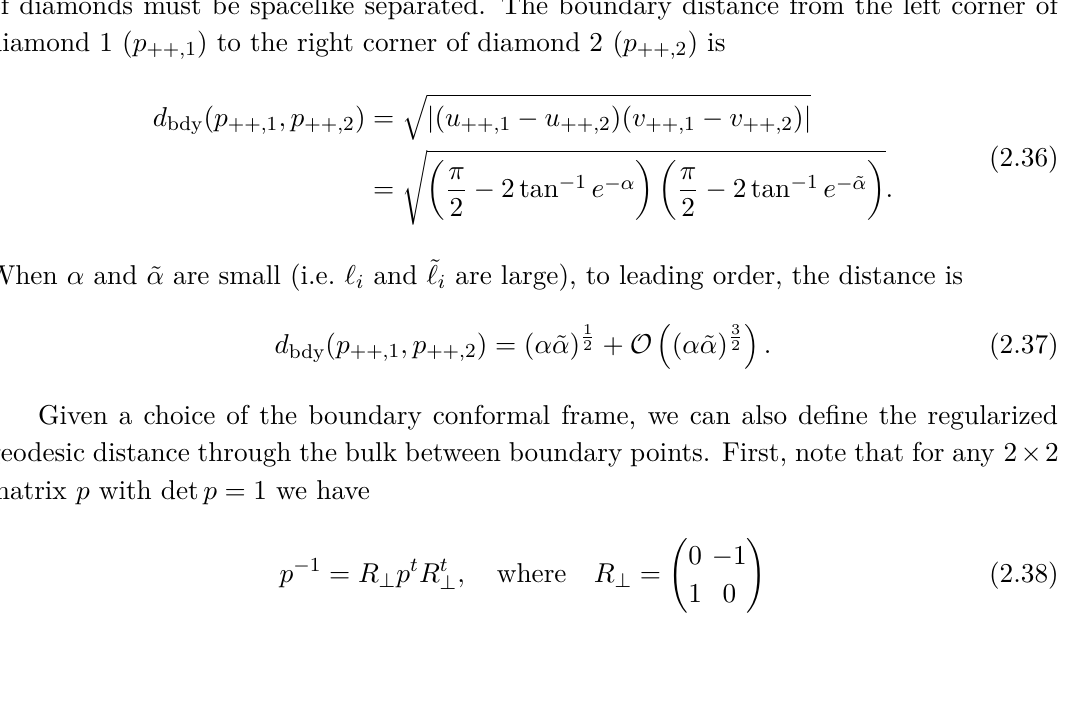
, p , p , and p correspond to the corners of the ++ ,i −− ,i − + ,i + − ,i = ˜ ‘ = 3 for the non-rotating case, and in (b) the parameters are i i